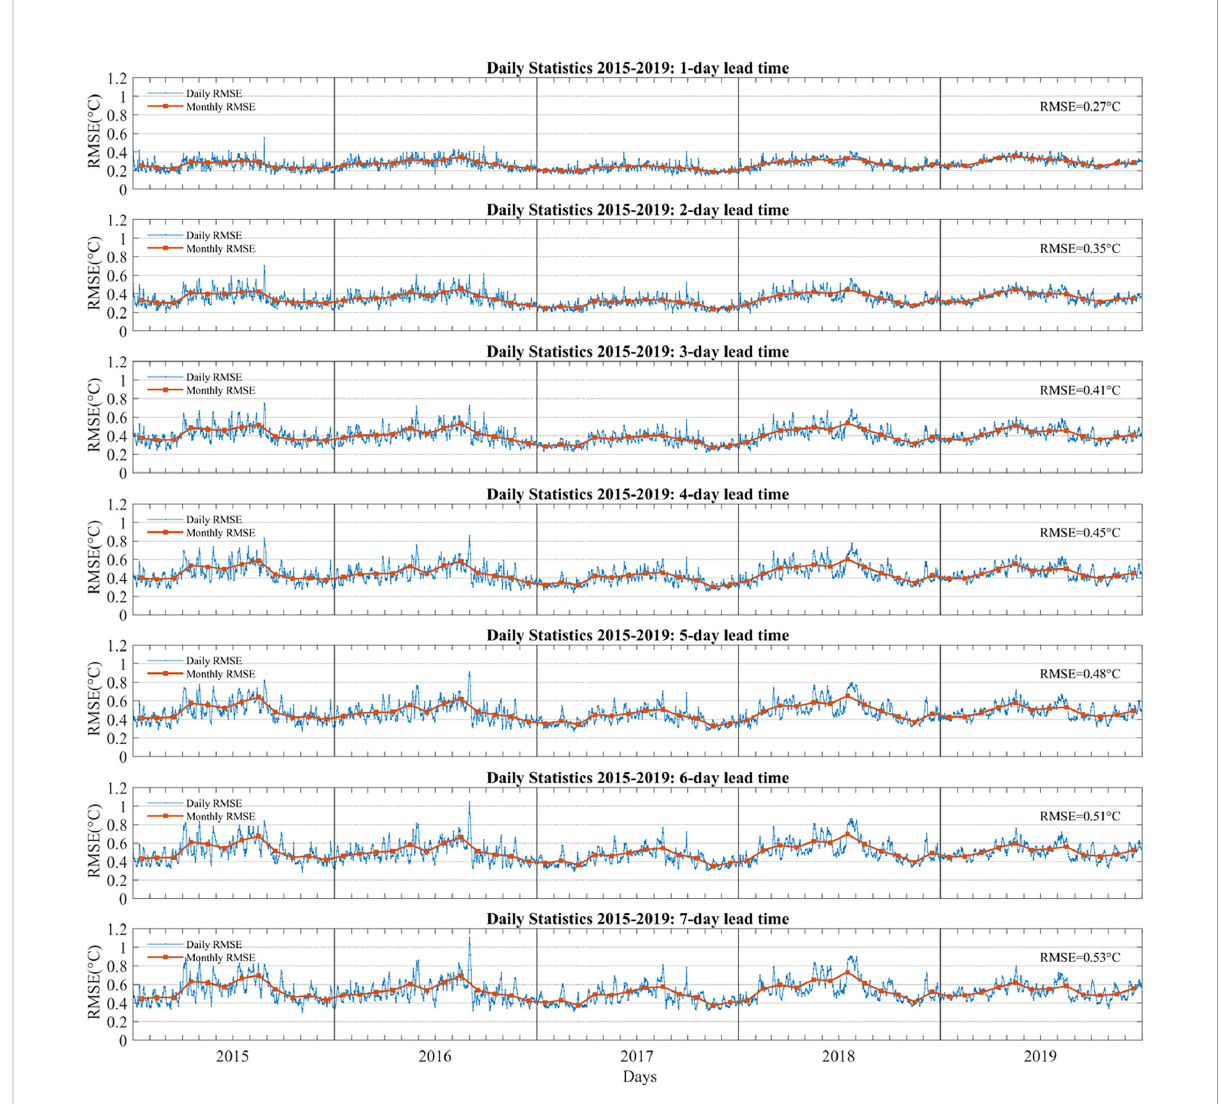
FIGURE 2 The daily RMSE (blue dots and line) and monthly RMSE (red dots and line) between predicted SSTs of the 3DConv-LSTM and OSTIA during 2015-2019 at a 1- to 7-day lead